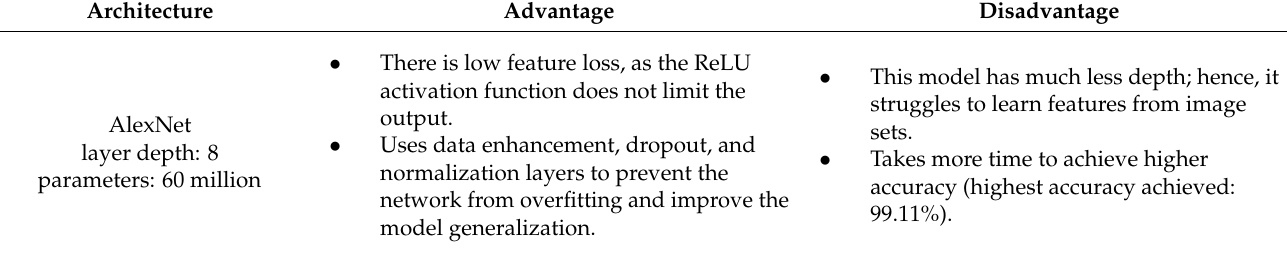
Table 4. The advantages and disadvantages of the AlexNet, ResNet, and GoogLeNet CNN architecture [34,35]. Architecture Advantage